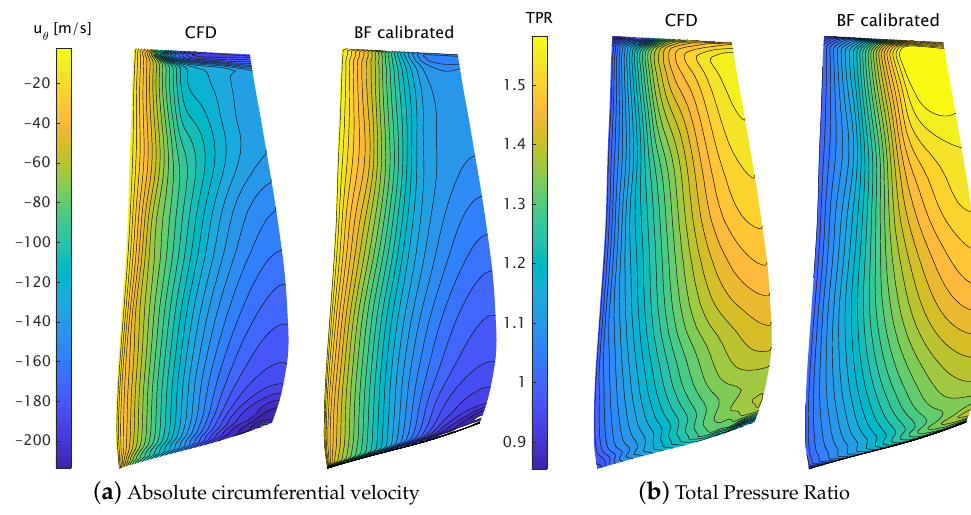
Figure 14. Blade contours at near-stall for reference CFD solution and calibrated